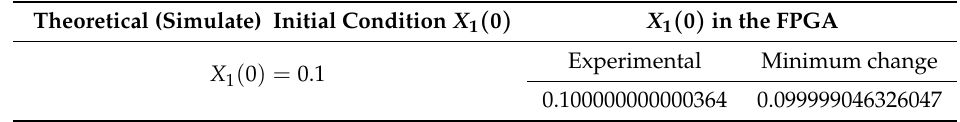
Figure 6. Image recovered from Lena when using a slightly different key (Sensitivity Analysis). ( a ) Recovered image; ( b ) Histogram of the recovered image. Table 2. Sensitivity of the Rössler system implemented in FPGA.